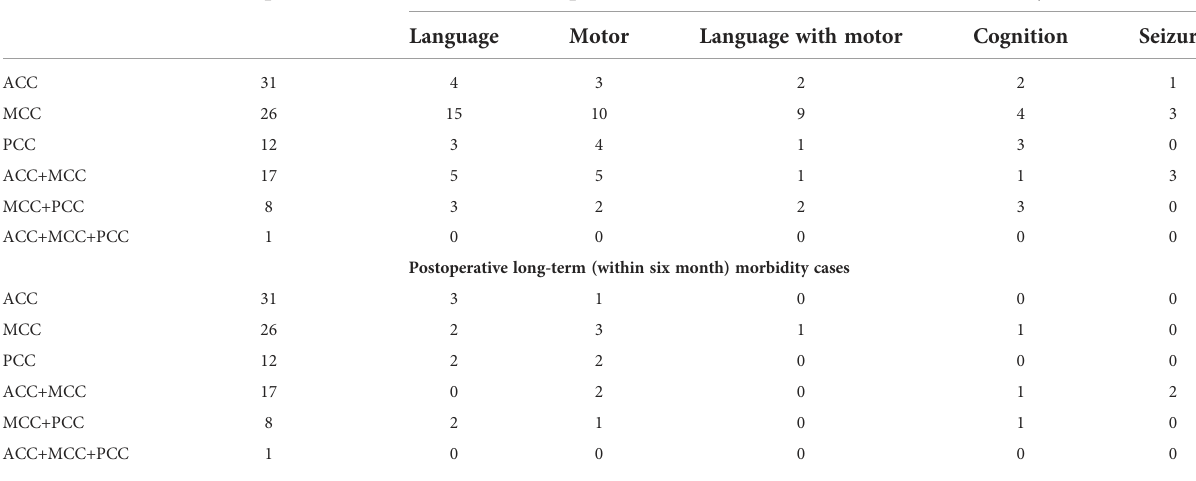
TABLE 3 Summary of function de fi cits and clinical symptoms in classi fi ed groups.